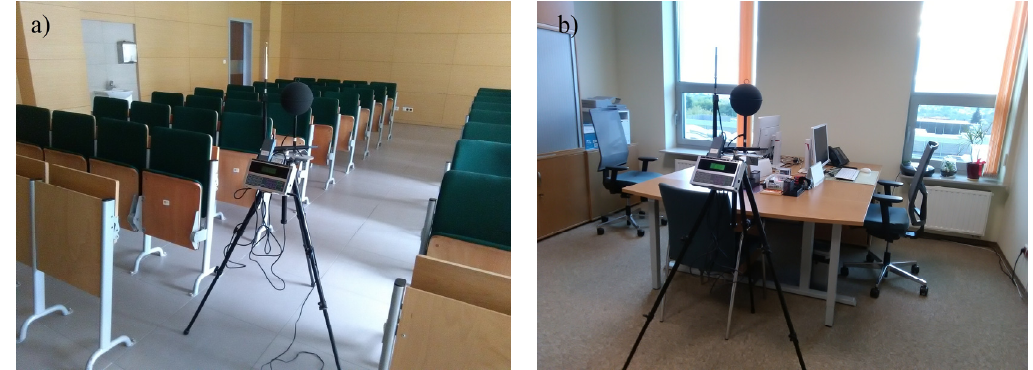
Figure 5. Experimental set-up: microclimate meter in the lecture room in Energis building ( a ) and in the office room in the courthouse ( b ).